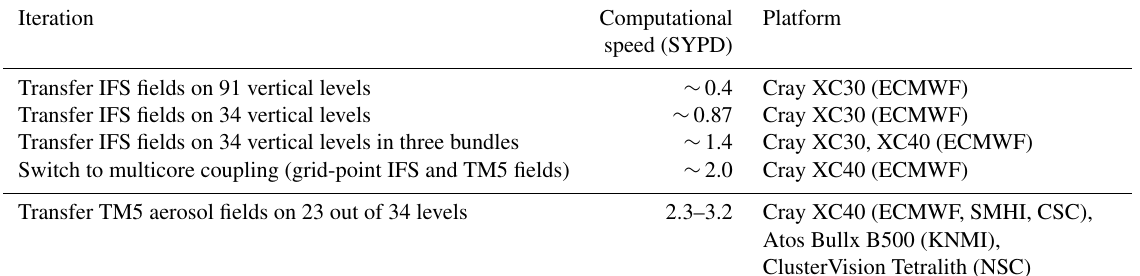
Table 7. Computational speed in simulated years per day (SYPD) for different implementations of the data exchange between TM5 and IFS. The benchmark tests were primarily conducted on the high-performance computer of the ECMWF. The performance with the final CMIP6 configuration is also reported for additional platforms of the Swedish Meteorological and Hydrological Institute (SMHI); the IT Center for Science, Finland (CSC); the Royal Netherlands Meteorological Institute (KNMI); and the Swedish National Supercomputer Centre (NSC). Iteration Computational Platform speed